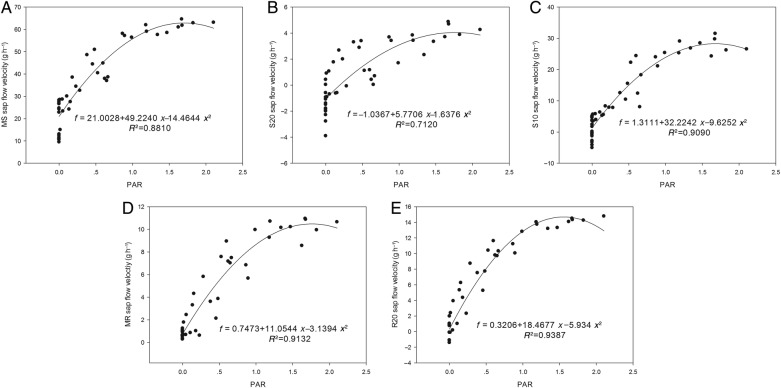
Correlation between sap flow velocity and PAR simulated by two-order line regression for each curve with 95 % CI as generated sigma plot 12.0. The scatter dot plot shows observed data from the field experiment site. The curve represented fit curve with the significant equation. (A) For the main stem with a diameter of ∼30 cm (MS), (B) for the stem with a diameter of ∼20 cm (S20), (C) for the stem with a diameter of ∼10 cm (S10), (D) for the main root with a diameter of ∼30 cm (MR) and (E) for the root with a diameter of ∼20 cm (R20).